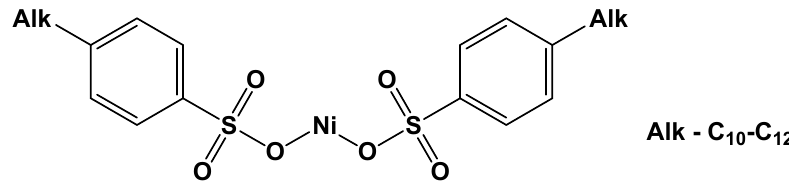
Figure 4. The proposed structural formula of Ni ABSA.